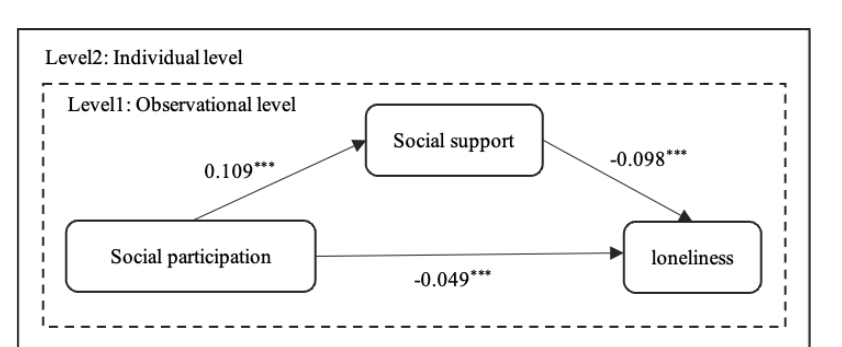
Figure 4. The influence of social participation on loneliness. *** p < 0.001 . Table 6. Significance test results of mediating effect of social support.